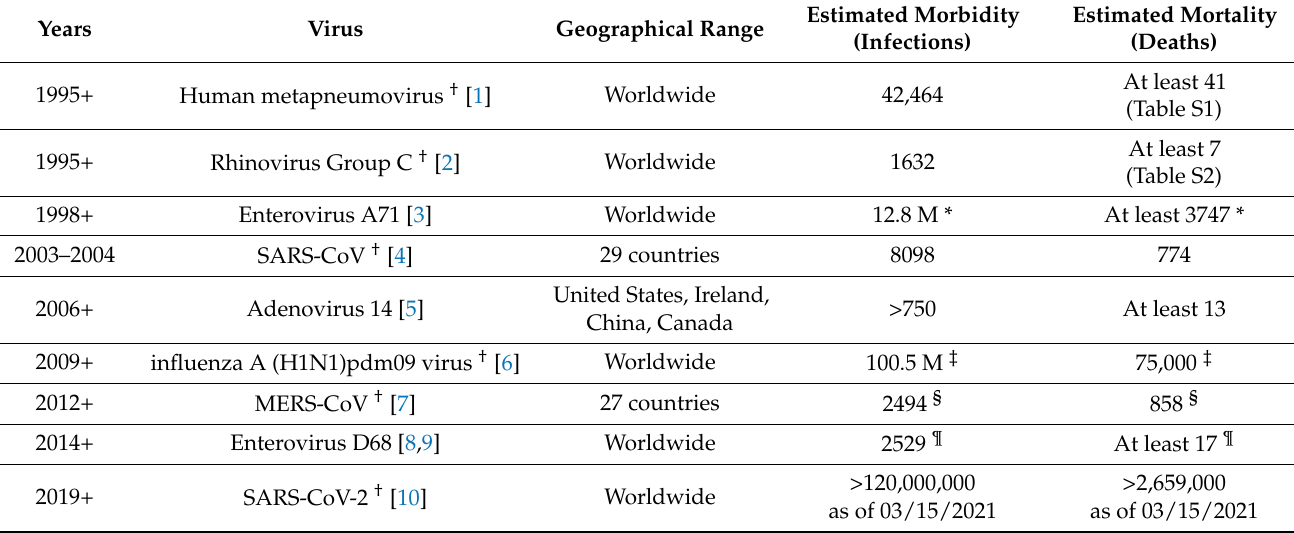
Table 1. Recent epidemics of emerging or reemerging respiratory